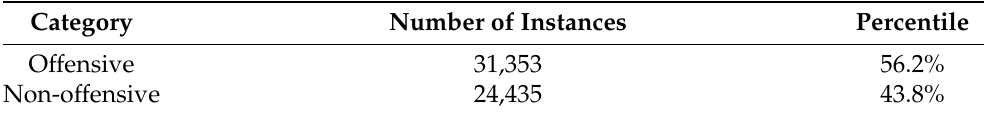
Table 2. Category of tweets in the